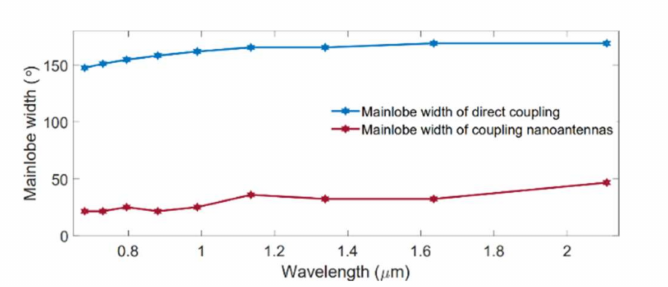
Figure A3. Plot of the main lobe width for the polar diagrams in Figure